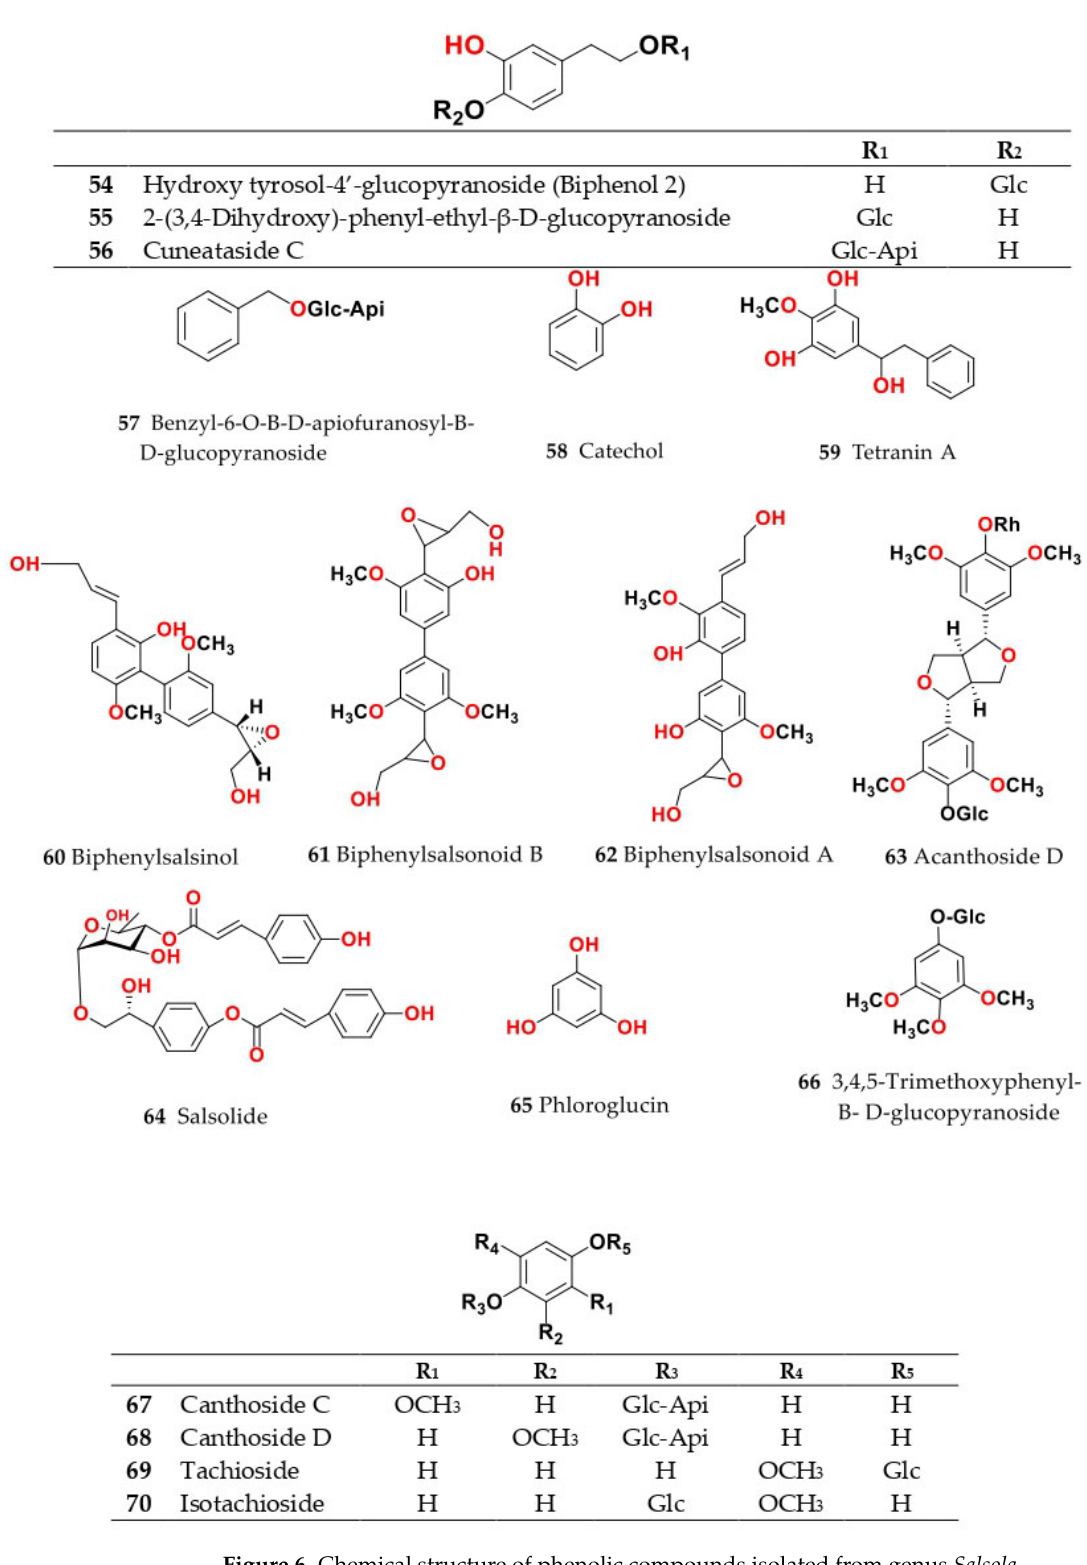
Figure 6. Chemical structure of phenolic compounds isolated from genus Salsola.